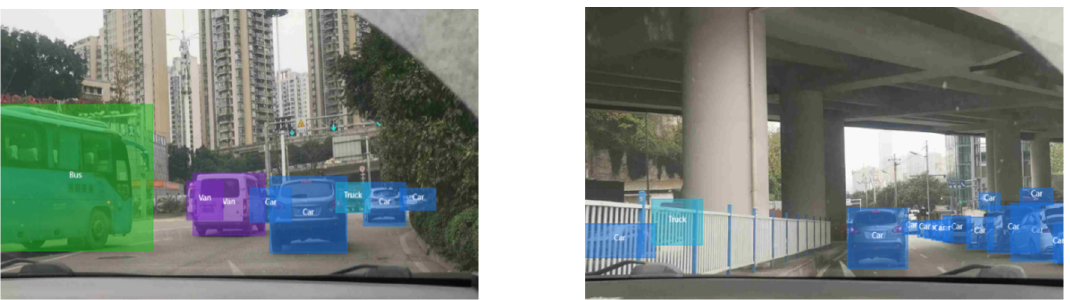
Figure 7. Sample of the homemade dataset section label.